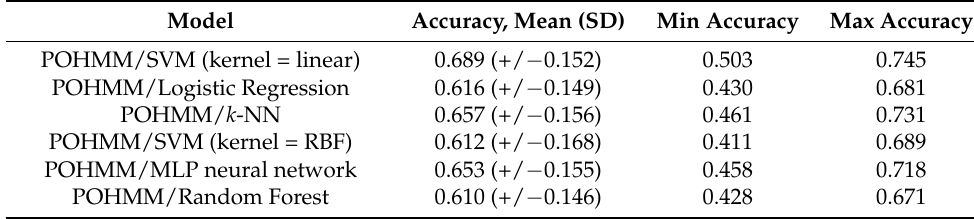
Table 6. Different hybrid models’ accuracy on POHMM transition parameters.